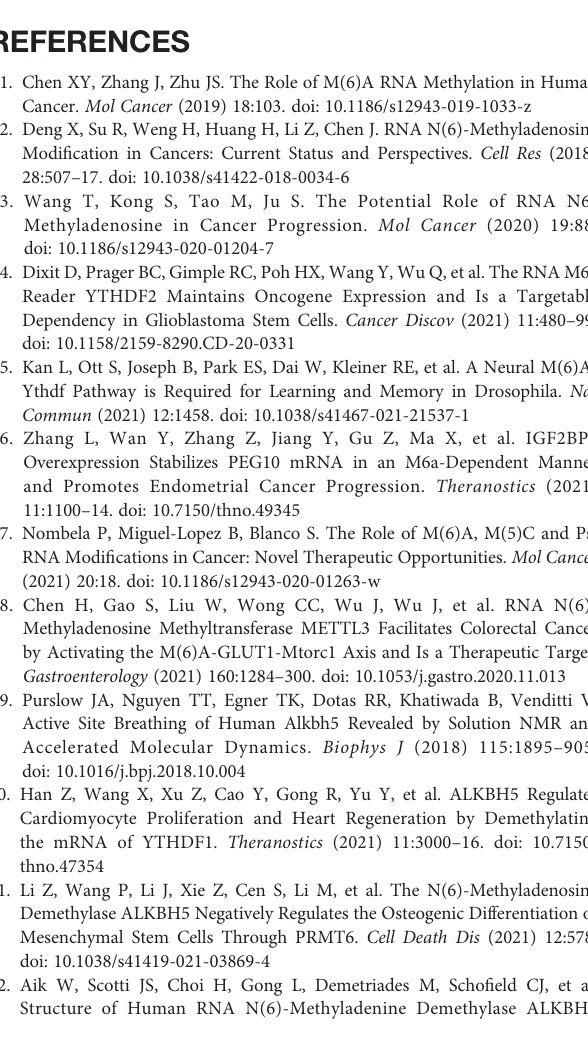
ALKBH5 and ICP genes, while the green dots represent the negative correlation between ALKBH5 and ICP genes. Supplementary Figure 12 | The relationships between the expressions of miRNAs and grade and prognosis in glioma. The relationships between the expressionsofhas-miR-193a-3p (A,B) ,has-miR-362-3p (C, D) ,has-miR-193b (E, F) and miR-329 (G, H) and grades or prognosis of primary and recurrent glioma in CGGA microRNA array database. *P<0.05, **P<0.01, ***P<0.001, ****P<0.0001. Supplementary Figure 13 | The abundance of ALKBH5 mRNA expression in a variety of glioma cell lines by CCLE database. Cell lines labeled in red (U87-MG, U251-MG, A172 and LN229) were used to detect the relative expression level of ALKBH5 in this study via qPCR. Supplementary Figure 14 | The biological functions of ALKBH5 in glioma. (A) Veri fi cationofoverexpressionef fi ciencyofALKBH5viaRT-qPCRinLN229celllines. The biological functions of ALKBH5 on LN229 cell lines were veri fi ed by CCK-8 (B) , wound healing (C) and Transwell (D) experiments. *P<0.05, **P<0.01, ***P<0.001, ****P<0.0001. Supplementary Figure 15 | Morphological changes of THP1 cells induced by PMA, IL-4 and IL-13. Morphological changes of THP1 cells were observed 24 h after PMA induction and 24h/48 h after IL-4 and IL-13